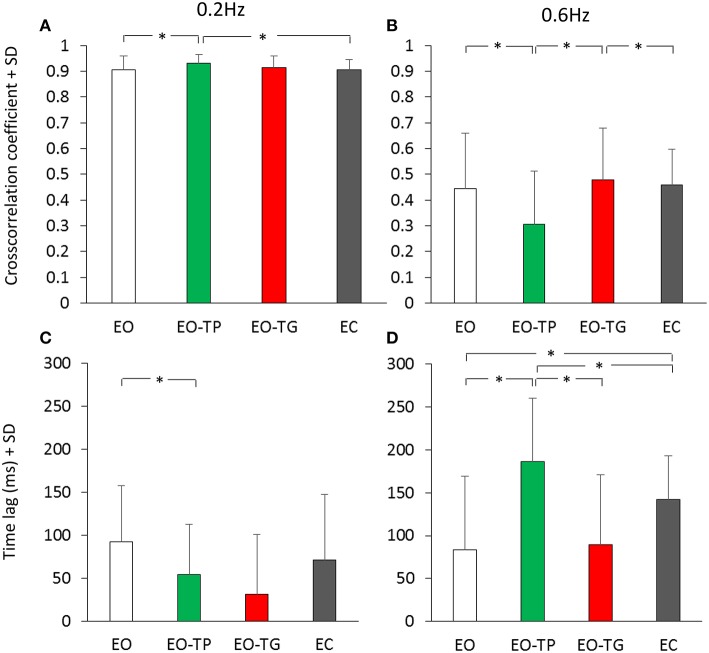
Cross-correlation between head and platform displacement. (A,B) mean cross-correlation coefficient (CC) calculated for the 0.2 Hz (A) and 0.6 Hz (B) translation frequency. (C,D) time-lag between head and platform displacement at 0.2 Hz (C) and 0.6 Hz (D) translation frequency. White bars refer to the EO condition, green bars to the EO-TP condition, red bars to the EO-TG condition and gray bars to the EC condition. The CC coefficients were positive under all visual conditions, indicating in-phase movement of head and platform, and were greater at 0.2 Hz than at 0.6 Hz translation frequency. Mean time-lags were positive under all visual and frequency conditions indicating that the head displacement followed the platform displacement. *Indicates a significant difference.